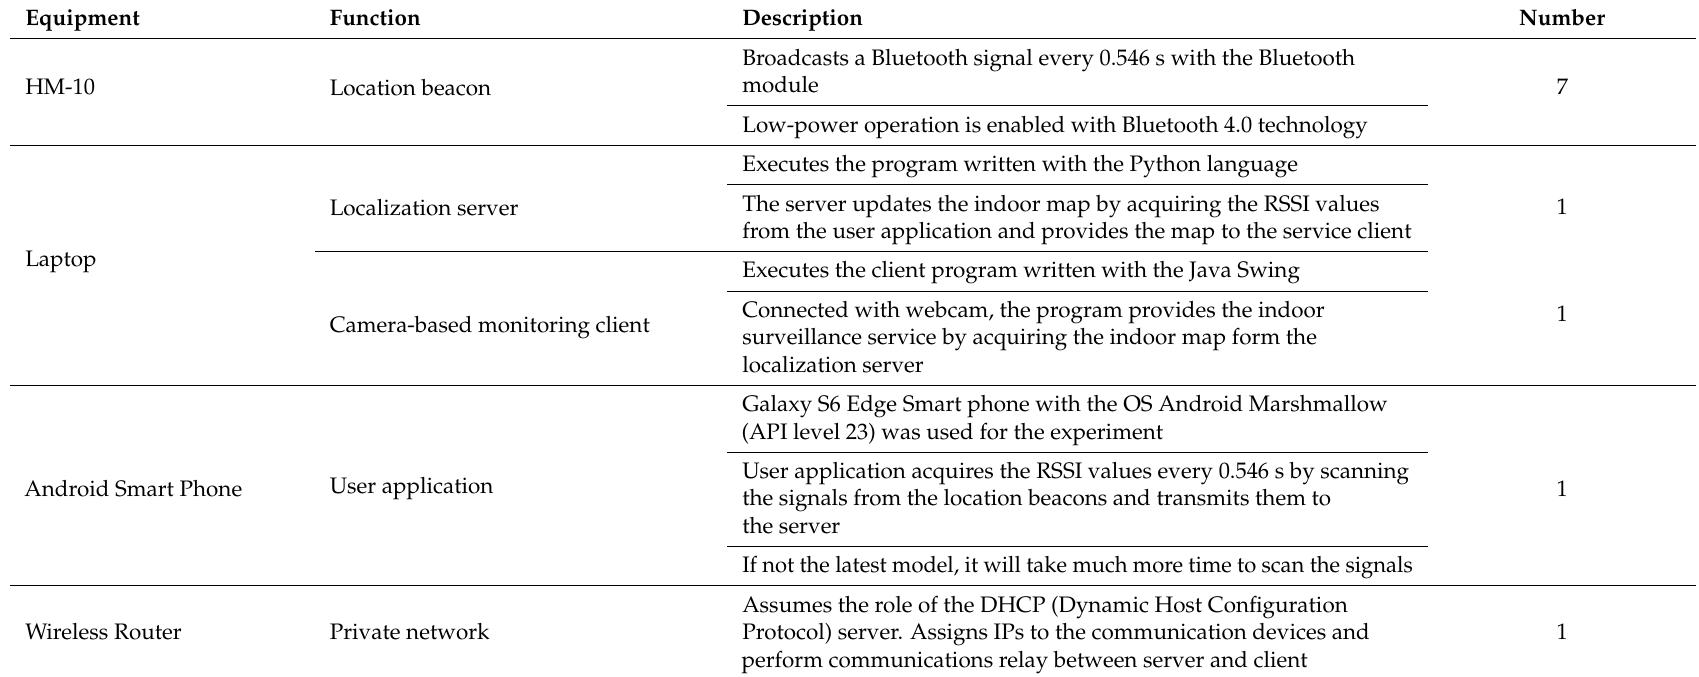
Table 4. List of equipment used for the